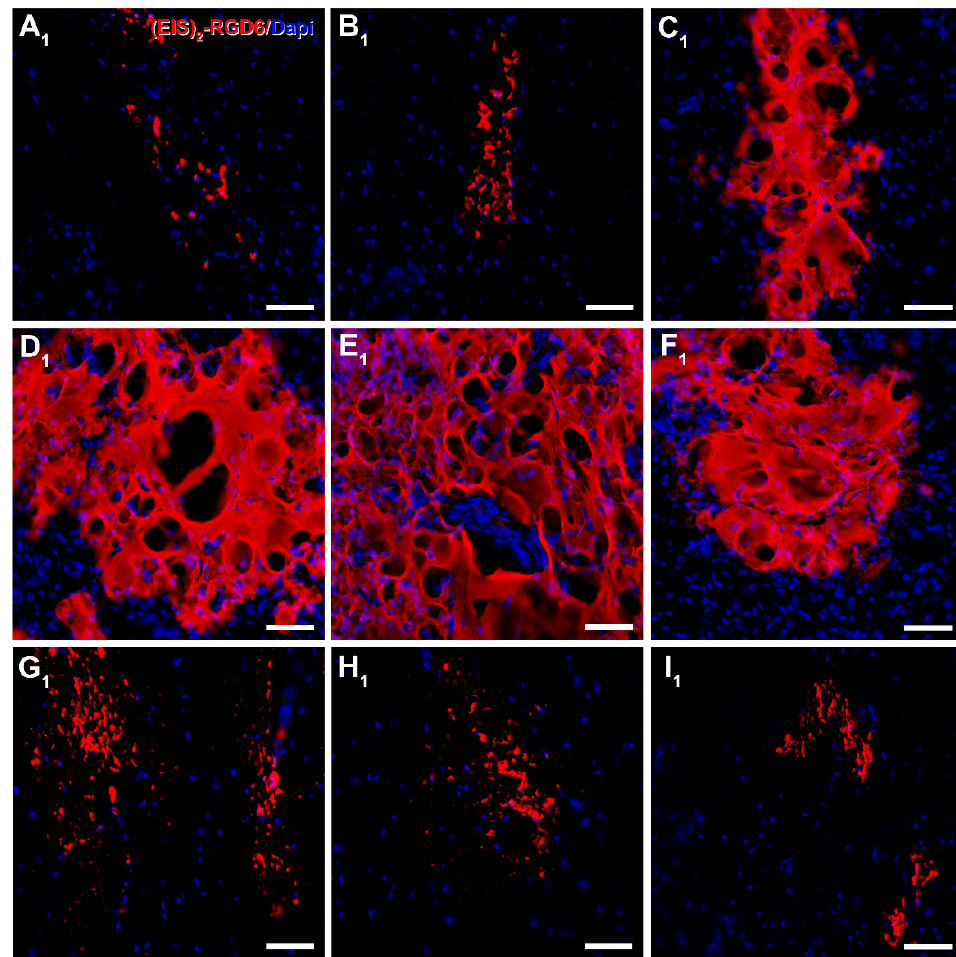
Figure 12. Qualitative microscopic analysis of (EIS) 2 -RGD6 structure at 42 days post-injury. Representative higher magnification images of spinal cord sections processed for the visualization of biotinylated (EIS) 2 -RGD6 at 42 days post-injury [experiment (EIS) 2 -RGD6 II], showing (EIS) 2 -RGD6 structure at the following representative rostro-caudal spinal cord levels: ( A 1 ) 7.2 mm rostral; ( B 1 ) 5.4 mm rostral; ( C 1 ) 3.6 mm rostral; ( D 1 ) 1.8 mm rostral; ( E 1 ) 0 mm; ( F 1 ) 1.8 mm caudal; ( G 1 ) 3.6 mm caudal; ( H 1 ) 5.4 mm caudal; and ( I 1 ) 7.2 mm caudal from the injury epicentre. Scale bars, 50 µm. Please note that the specific areas shown in these images are highlighted in Figure 10.